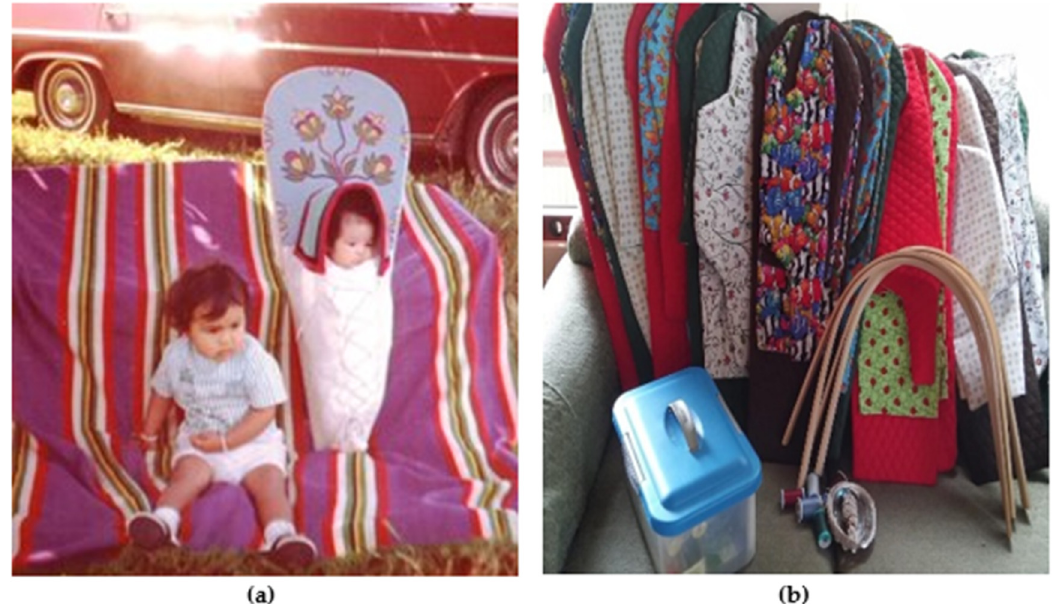
Figure 1. Cradleboards are a form of traditional engineering for carrying protecting babies ( a ) panel a includes the fifth author at one year of age next to her sister in a traditional Nez Perce cradleboard; ( b ) panel b showcases NAWDIM contemporary cradleboard class materials.